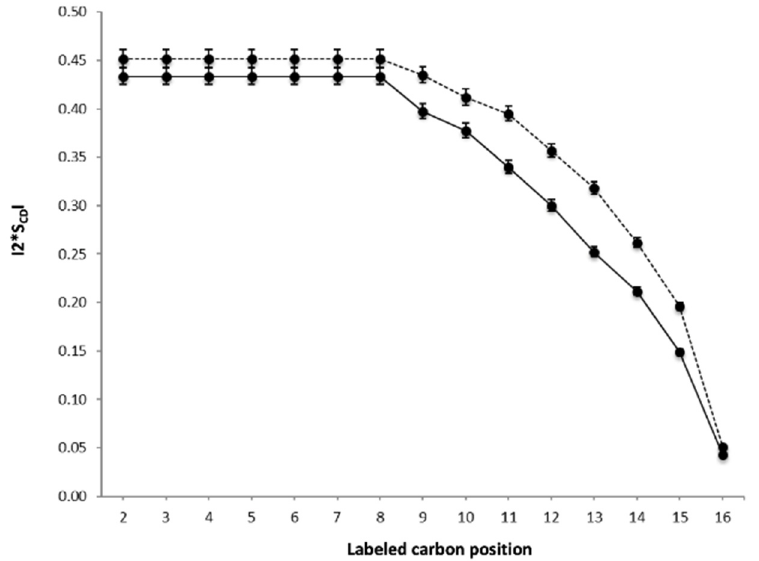
Figure 6. ssNMR analysis. SCD order parameters of dPOPC chains as a function of the labeled carbon position, at 310K, for a mixture of dPOPC (“reporter lipid”) and E. coli polar extract with and without Hfq-CTR (solid line for lipids alone and dashed line for lipids with Hfq-CTR). The presence of Hfq-CTR fibrils increases the SCD value, indicating an increase in membrane rigidity.